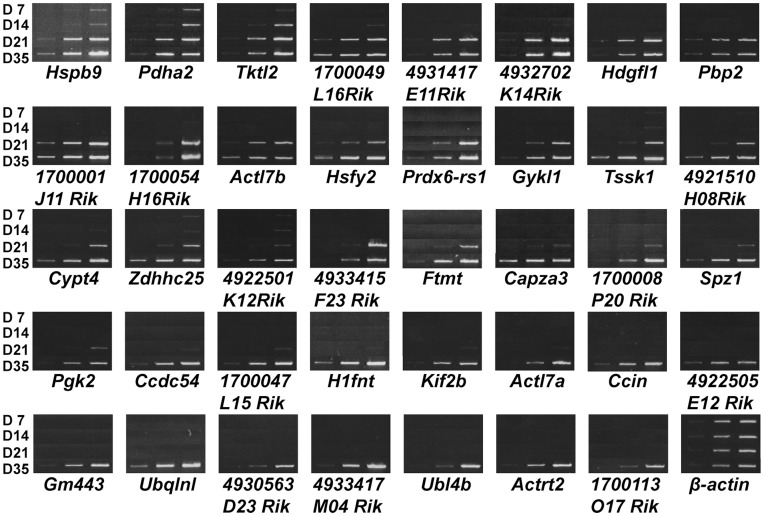
Expression levels of 39 spermatogenic cell-specific intronless genes are increased in later stages of spermatogenesis.Semiquantitative RT-PCR was carried out using total RNA isolated from D7, D14, D21, and D35 testes. The number of PCR cycles increases from left to right in each panel, as described in Table S2. The β-actin band represents equal expression levels for each stage. The absence of genomic DNA in RNA samples is shown in Figure S2.